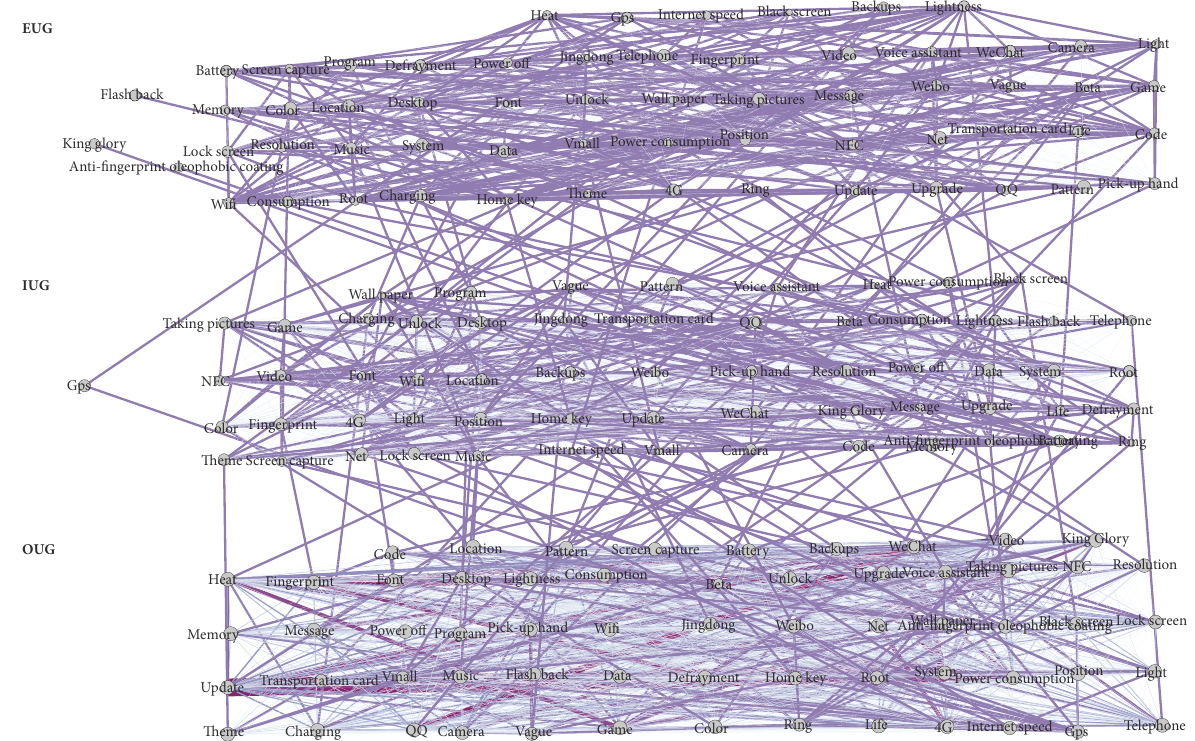
Figure 6: Consumer network based on multiplex